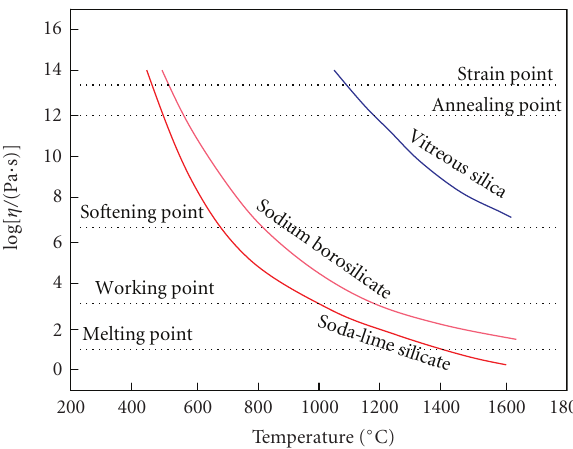
Figure 4: Viscosity of amorphous silicates and important techno- logical points in glass manufacture industry (after